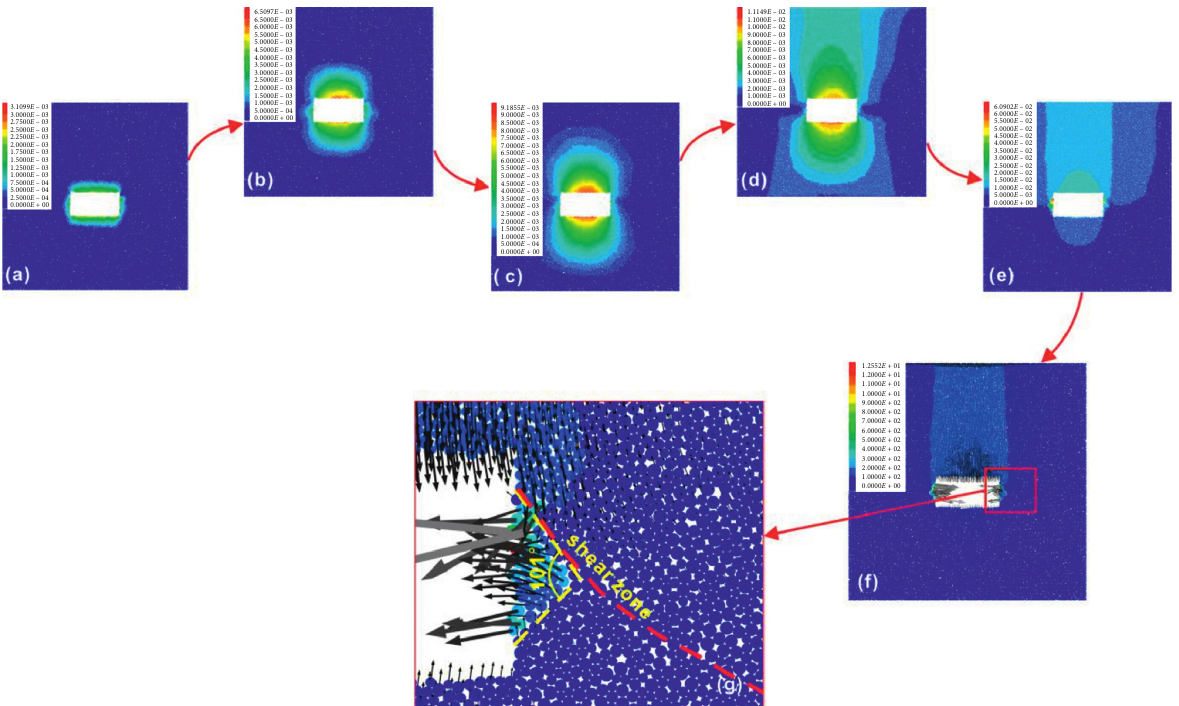
Figure 10: Evolution of displacement. (a) 100-step displacement cloud chart; (b) 300-step displacement cloud chart; (c) 500-step dis- placement cloud chart; (d) 1000-step displacement cloud chart; (e) 3000-step displacement cloud chart; (f) 5000-step displacement cloud chart and the displacement vector; (g) local enlargement of 5000-step displacement cloud chart and the displacement vector.